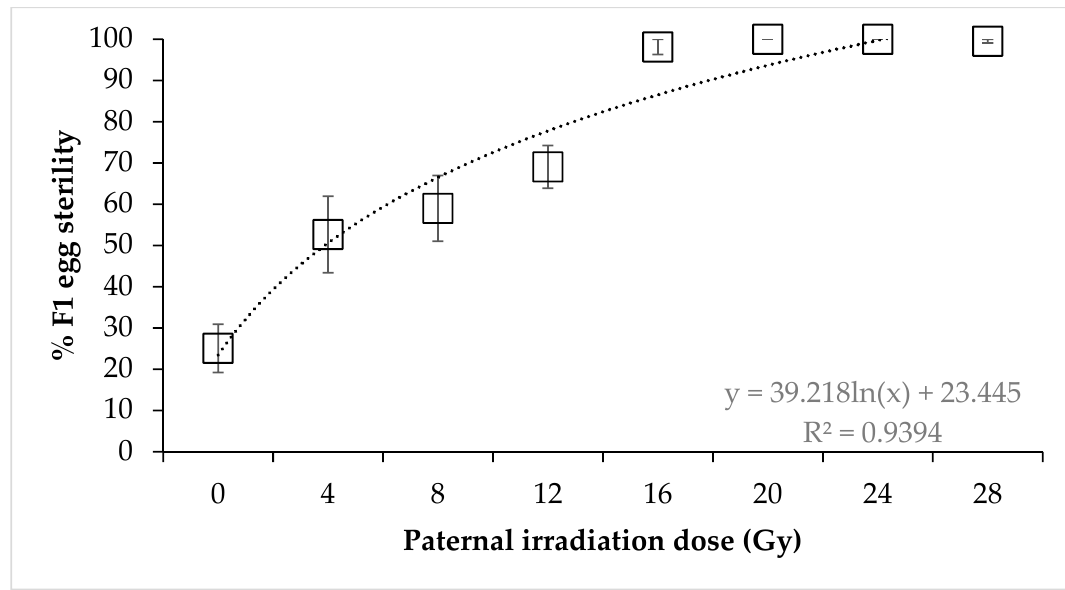
Figure 1. Sterility of Nezara viridula eggs after crosses of untreated females with irradiated males. Error bars show standard error (n = 15 crosses per dose).